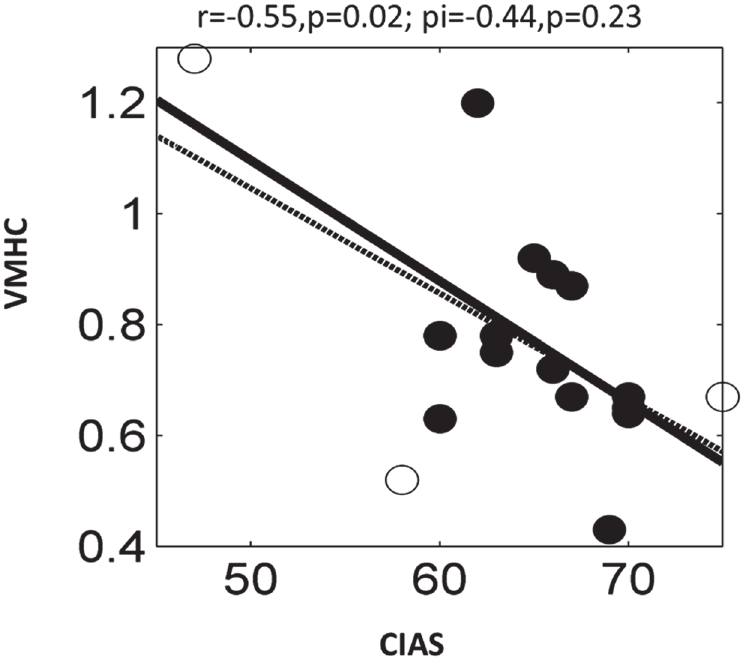
Fig 2. Correlation between VMHC in superior frontal gyrus (orbital part) and CIAS in participants with IGD. Solid and dashed lines represent the best-fit line of the Pearson ’ s and Shepherd ’ s correlations, respectively. Outliers are indicated by open circles. VMHC, voxel-mirrored homotopic connectivity; IGD, Internet gaming disorder; CIAS, Chen Internet Addiction Scale.